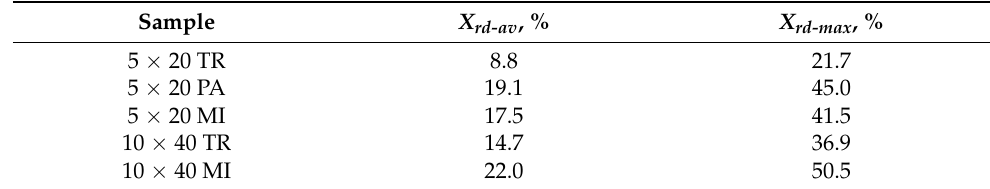
Figure 8. Calculated values of the percentage share of radiation in the joints: ( a ) results obtained for samples made of 5 × 20 mm bars; ( b ) results obtained for samples made of 10 × 40 mm bars. Table 5. The average and maximum values of X rd parameter obtained for individual samples.